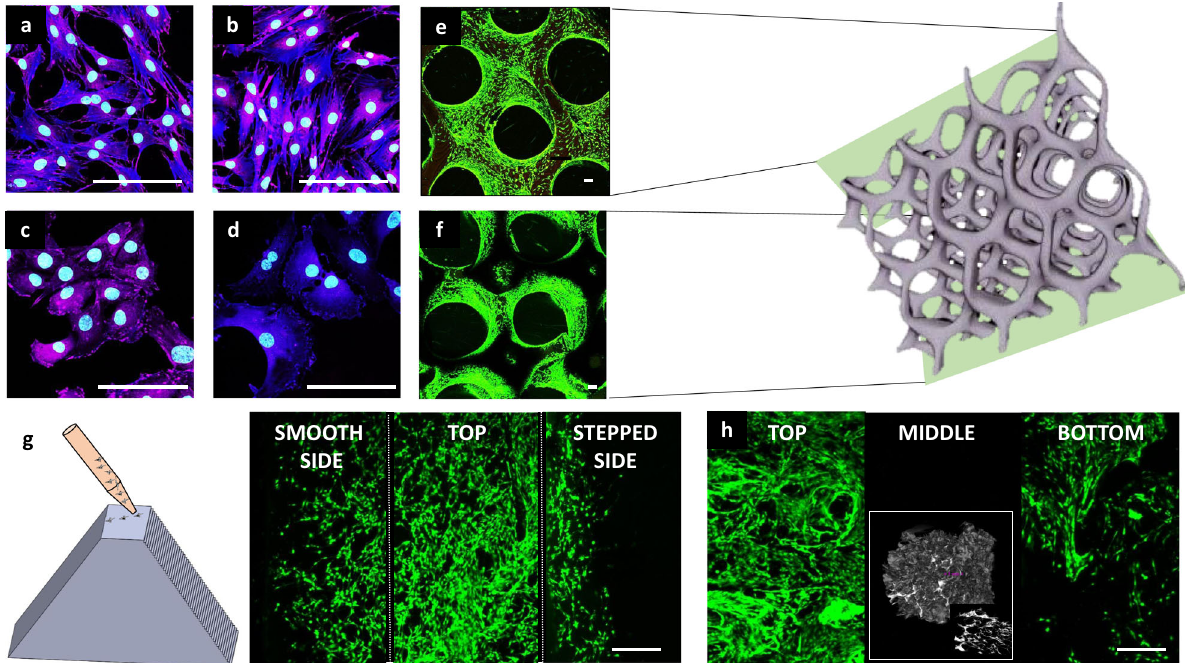
Fig. 3 Cellular response to polycarbonate-based materials. Representative images of adipocytes ( a , b ) and fi broblasts ( c , d ) for PTMPTCX ( a, c ) and PNTCTX scaffolds ( b, d ). Confocal image of adipocytes on 3D PTMPTCX scaffolds at the top ( e ) and bottom ( f ) after 7 days proliferation. (Image a – d Scale bar = 10 µ m; Image e, f Scale bar = 100 µ m). Representative printed stair-step pyramidal-structure (with smooth glass-surface cast and alternating stair-step design), with corresponding images from both surfaces overlaid to display cell (pre-osteoblasts) migration after 7 days ( g ), displaying no differences between surface morphology and cellular proliferation. Representative images of cellular proliferation throughout PTMPTCTX foam with images taken at the top of the scaffold (where cells were seeded), bottom of the scaffold, and from the middle of the scaffold after the same time ( h ), inset µ CT of foams. Scale bar = 500 µ